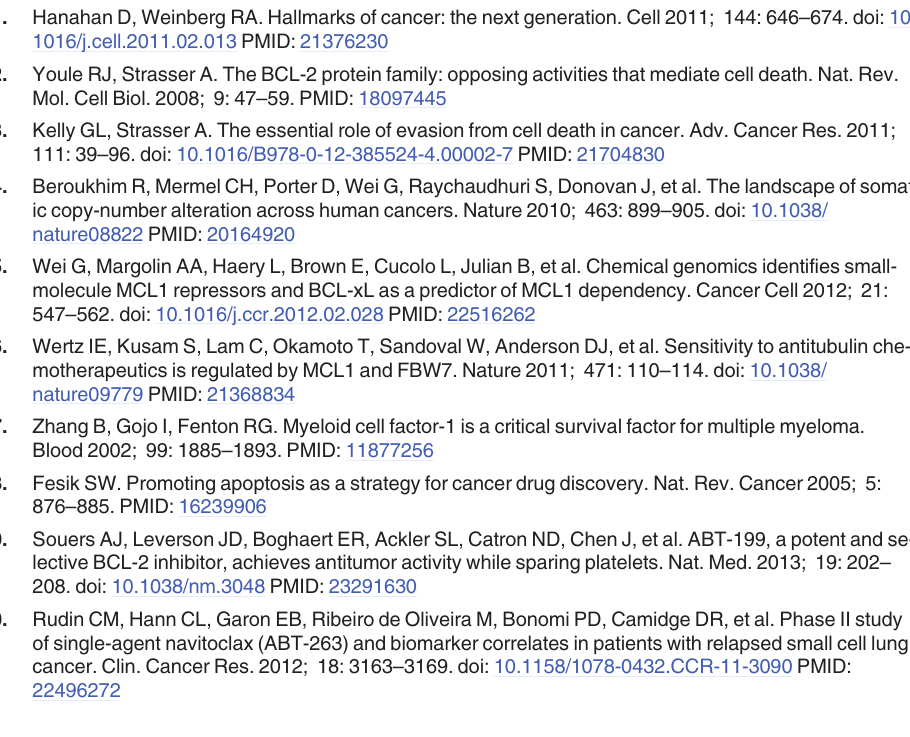
S1 Table. X-ray data processing and refinement